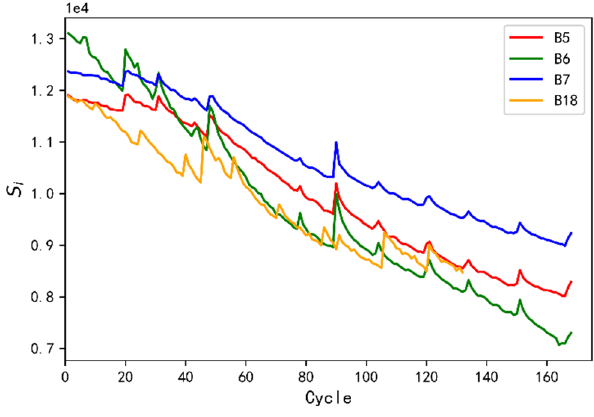
Figure 5. Change curves of the IVTs.